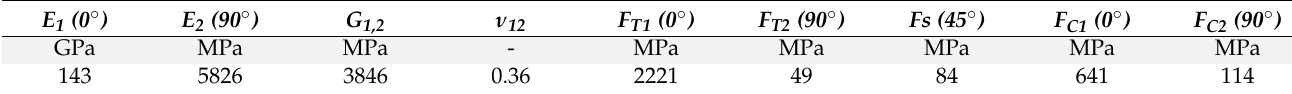
Table 2. Mechanical properties of CFRP